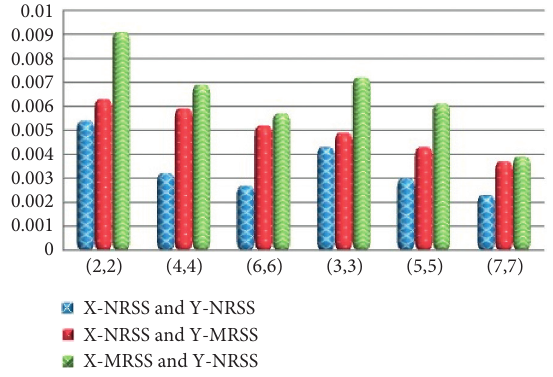
Figure 2: MSE of 􏽢 R at R � 0.8889.